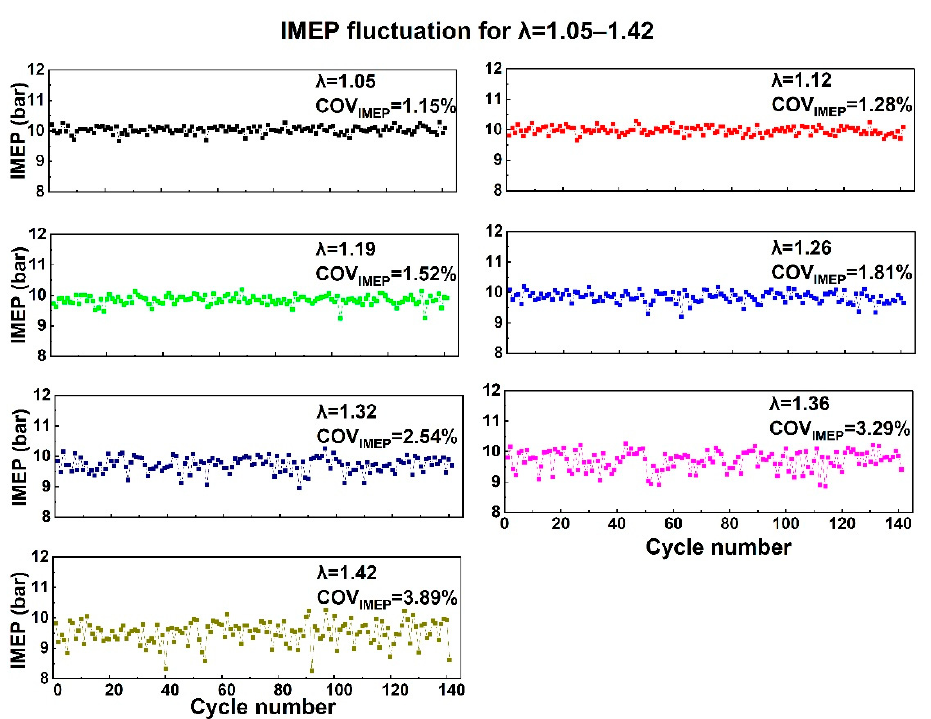
Figure 5. IMEP fluctuations under different λ conditions.